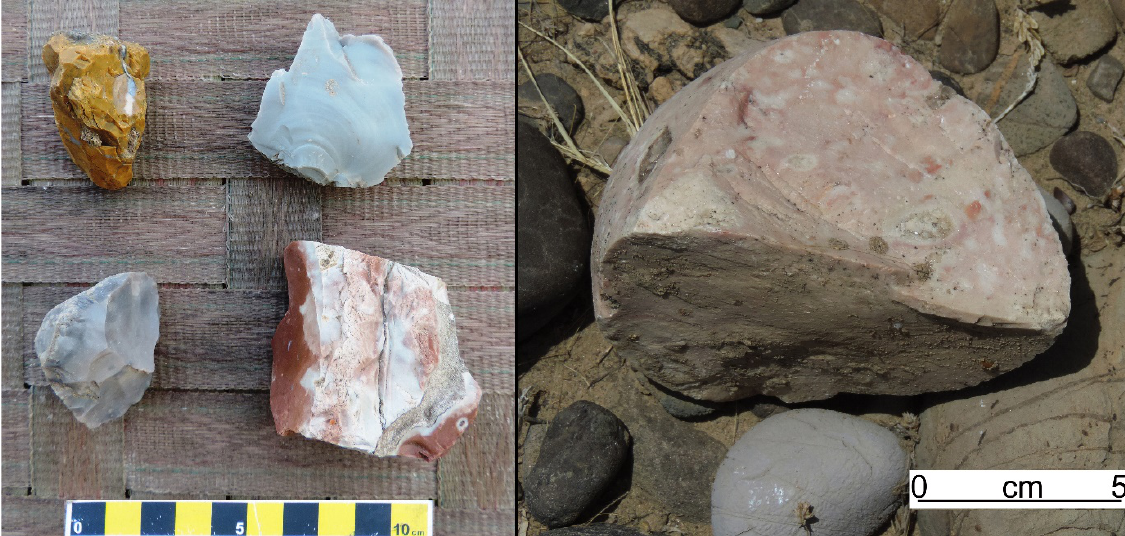
Figure 4. Natural chert pieces (left) and nodule (right) from the gravel terraces of Barrai Khuarra (photographs by R. Nisbet,